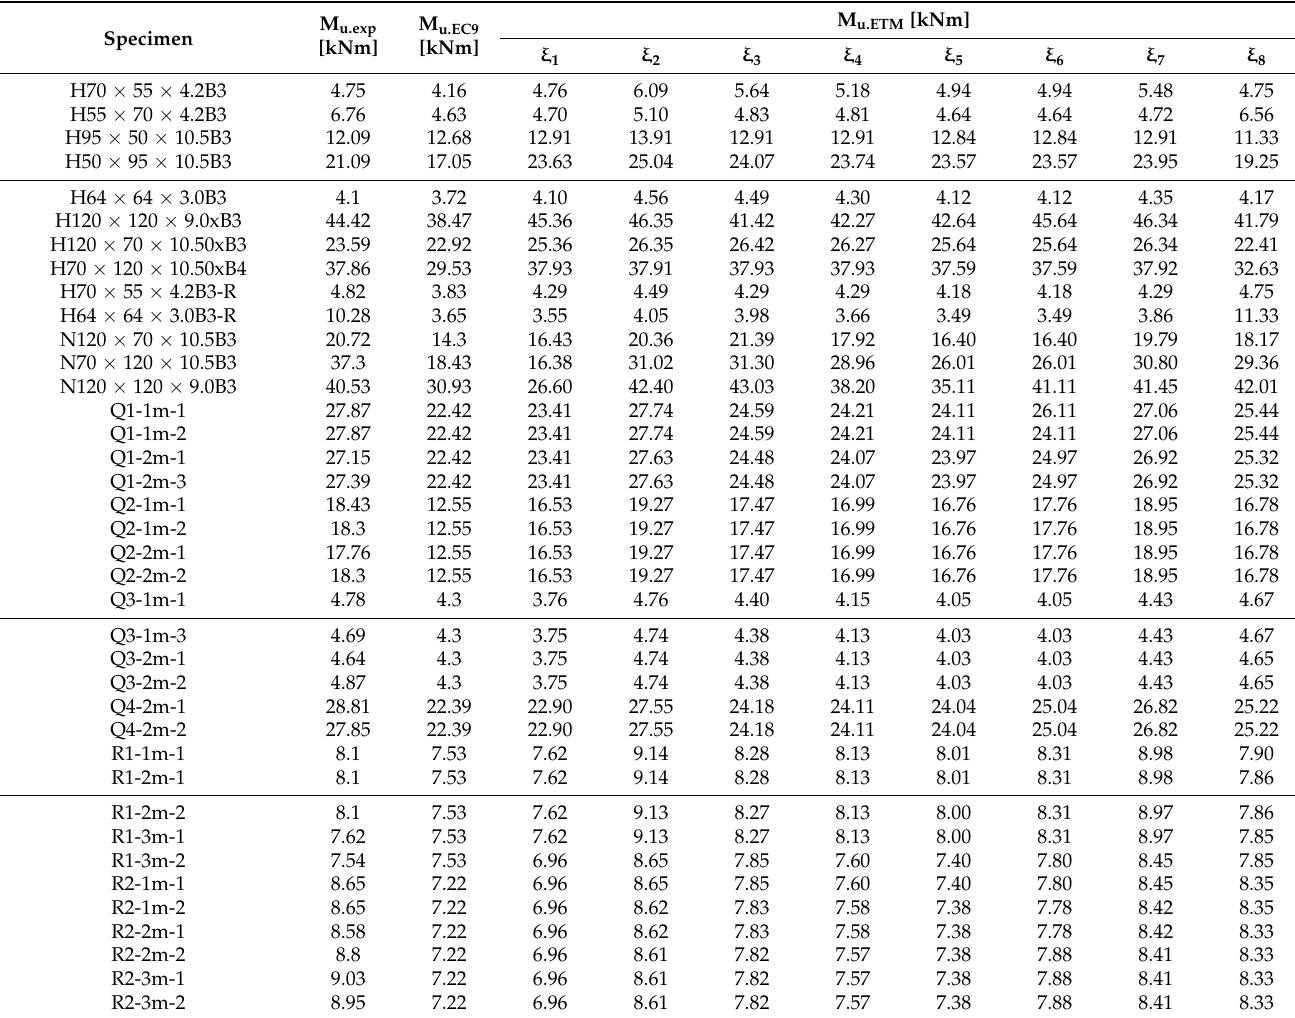
Table A5. Comparison between the theoretical and experimental results in the case of bending moment. Specimen